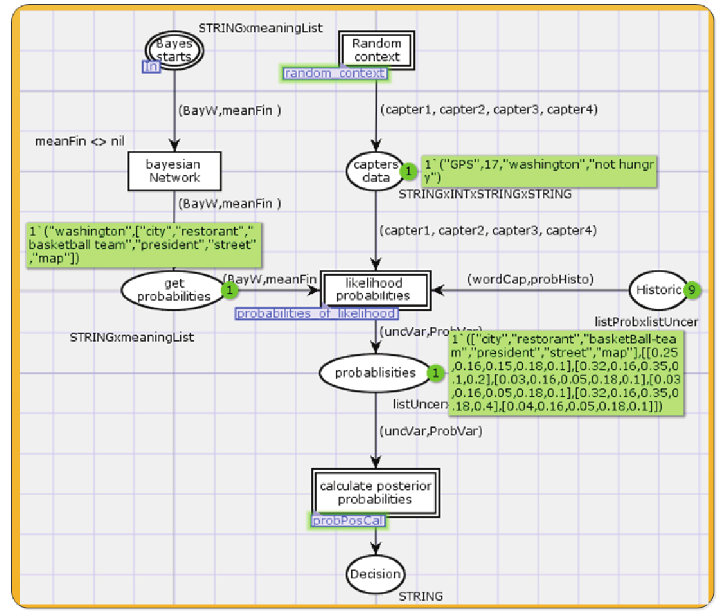
Fig. 15. Bayesian